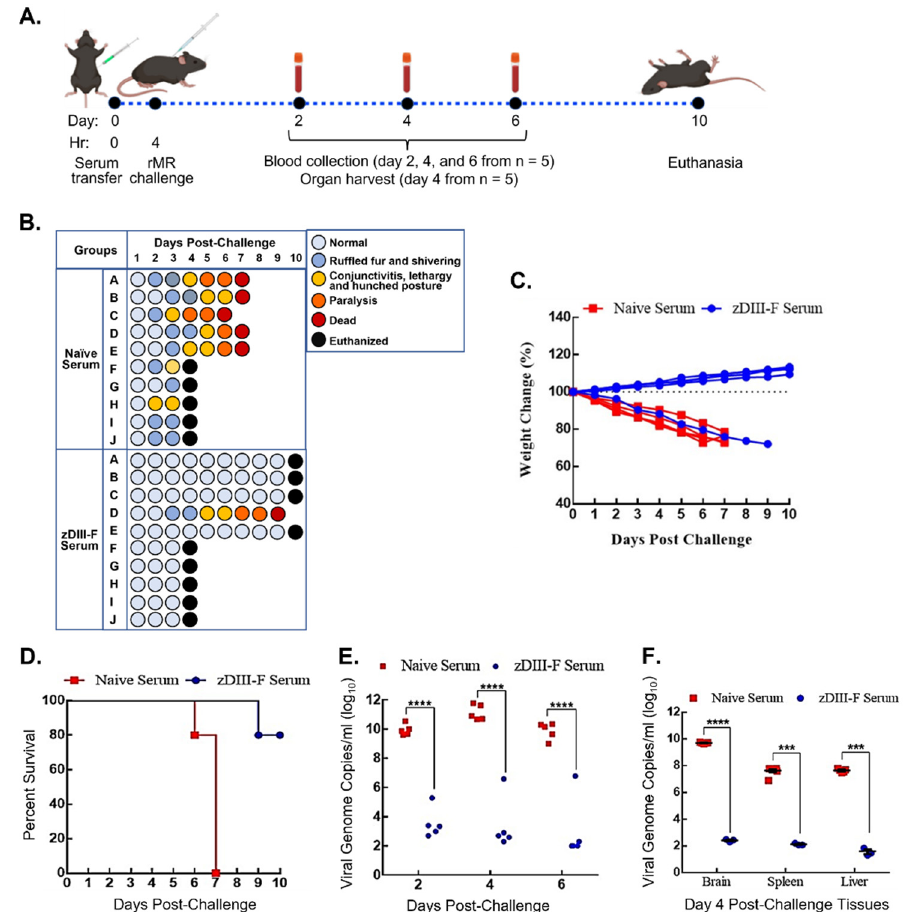
Figure 5. Passive transfer of sera from zDIII-F-vaccinated animals protects naïve animals from lethal ZIKV challenge. ( A ) Scheme for passive transfer of immune sera and lethal ZIKV challenge in four-week-old A129 mice. Mice were injected on day 0 with 200 µ L of PBS (n = 10) or pooled sera from zDIII-F-vaccinated animals (n = 10) s.c. at 0 hr and challenged with rMR (10,000 pfu/mouse) at 4 hr. Blood samples were collected on days 2, 4 and 6 post-lethal challenge from five animals in each group. Organs were harvested from the other five animals on day 4. All surviving animals were euthanized on day 10. ( B ) Clinical symptoms in individual mice (identified as A to J in each group) following lethal ZIKV challenge are shown. Percent weight change ( C ) and survival ( D ) of mice injected with immune sear from naïve or zDIII-F-vaccinated animals. ( E ) Viral genome copies in sera of animals (n = 5) in each group collected on days 2, 4 and 6 post-challenge. ( F ) Viral genome copies per gram of tissue (brain, spleen and liver) on day 4 post-challenge (n = 5) as measured by qRT-PCR. Data are presented as mean ± SEM. Two-way ANOVA was used to determine significance in panels ( E , F ). ***, p ≤ 0.001; ****, p ≤ 0.0001. Mice were divided into two groups: one group (n = 10) received sera obtained from mice that were administered with PBS (naïve serum group), while the other (zDIII-F group) (n = 10) received sera from mice vaccinated with zDIII-F. These sera were collected from the animals at 28 days post-vaccination that had been injected with PBS or zDIII-F and the